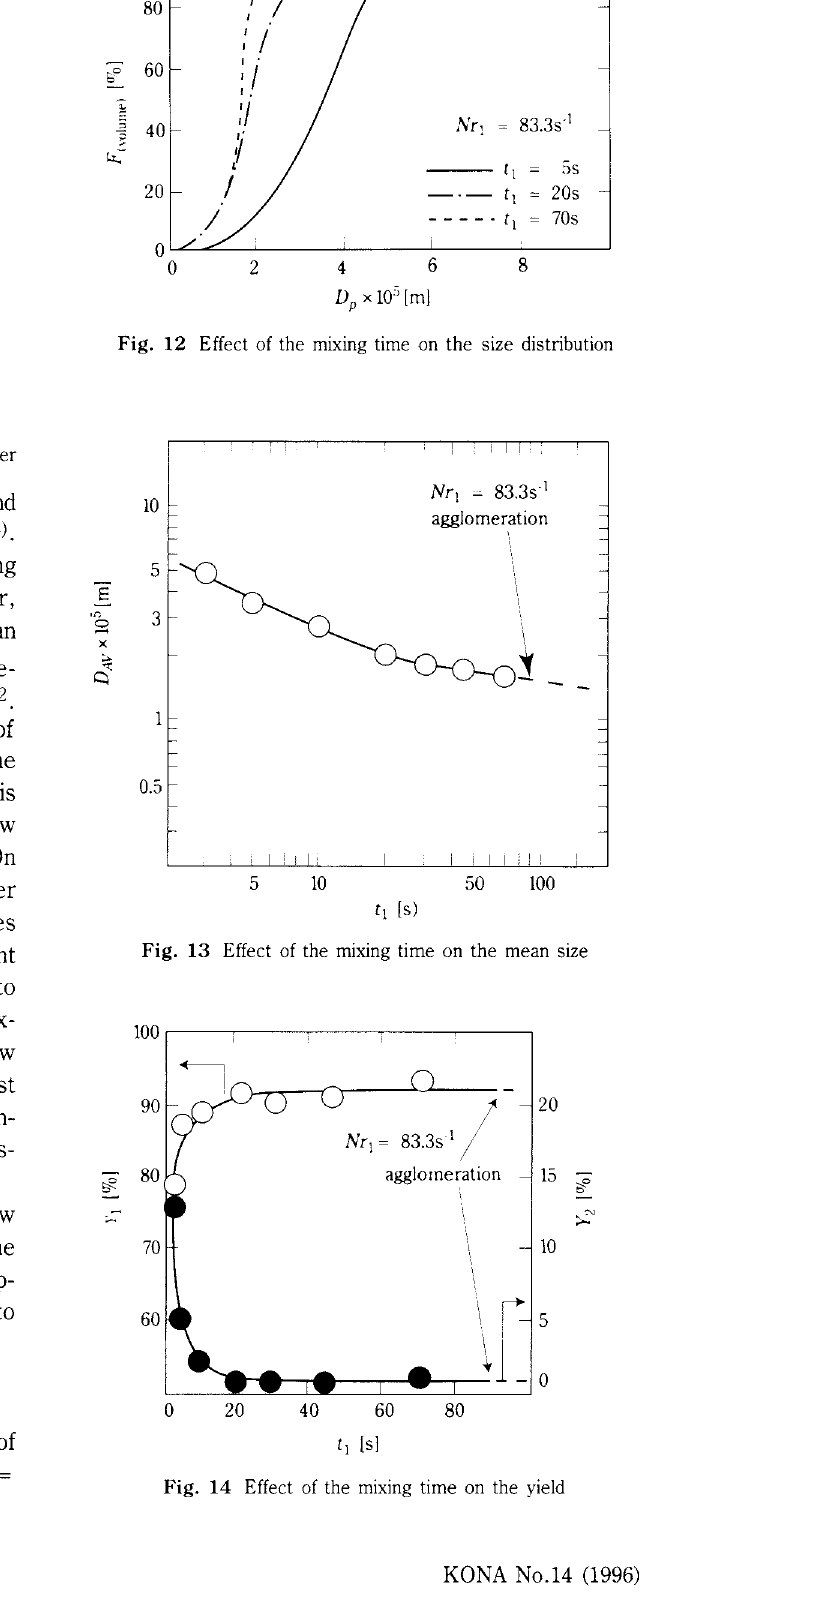
Fig. 14 Effect of the mixing time on the